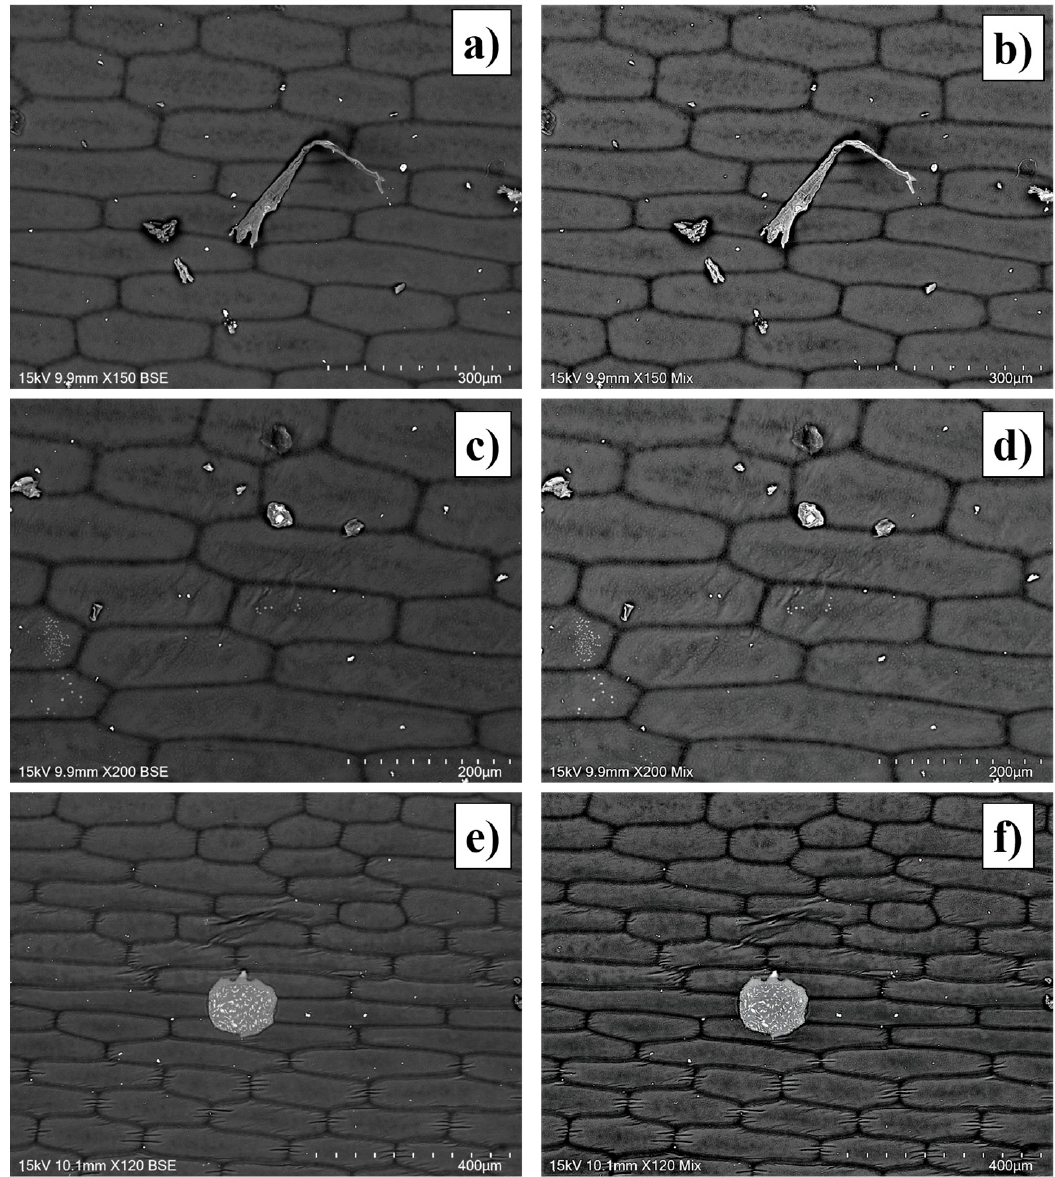
Figure 5. SEM images acquired in BSE (back scattered electrons) mode ( a , c , e ) or mix (BSE + secondary electrons) mode ( b , d , f ) evidencing the presence of particles of micrometric dimensions on Chlorophytum comosum leaves. In Figure 6, some punctual analyses performed on single particles are reported. While the particle analyzed in Figure 6a is probably a chloride, in Figure 6b,c, some aluminum silicates were